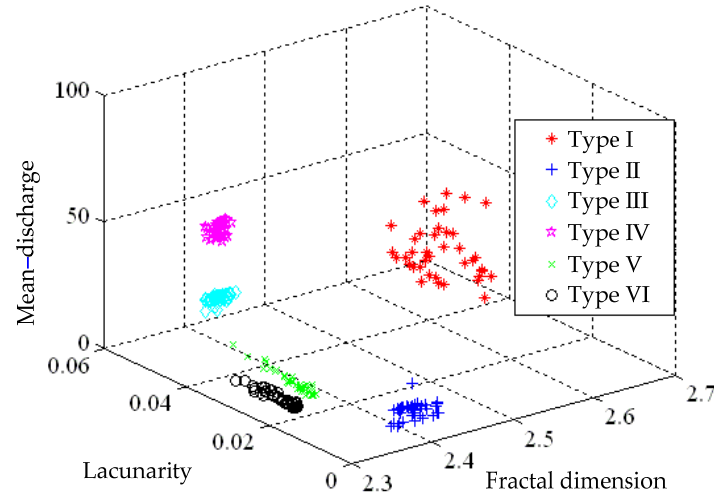
Figure 13. Feature distributions for time–frequency–energy 3D spectrums by IHHT. Table 2. Identification results by IHHT versus features FD ‐Λ‐ M.